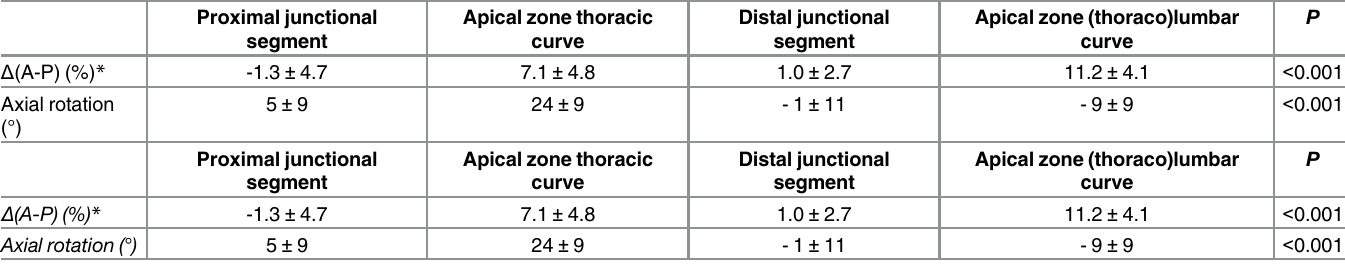
Table 4. Percentage anterior-posterior length discrepancy and axial rotation are shown for different regions of the scoliotic spine. Δ (A-P) = ante- rior-posterior length